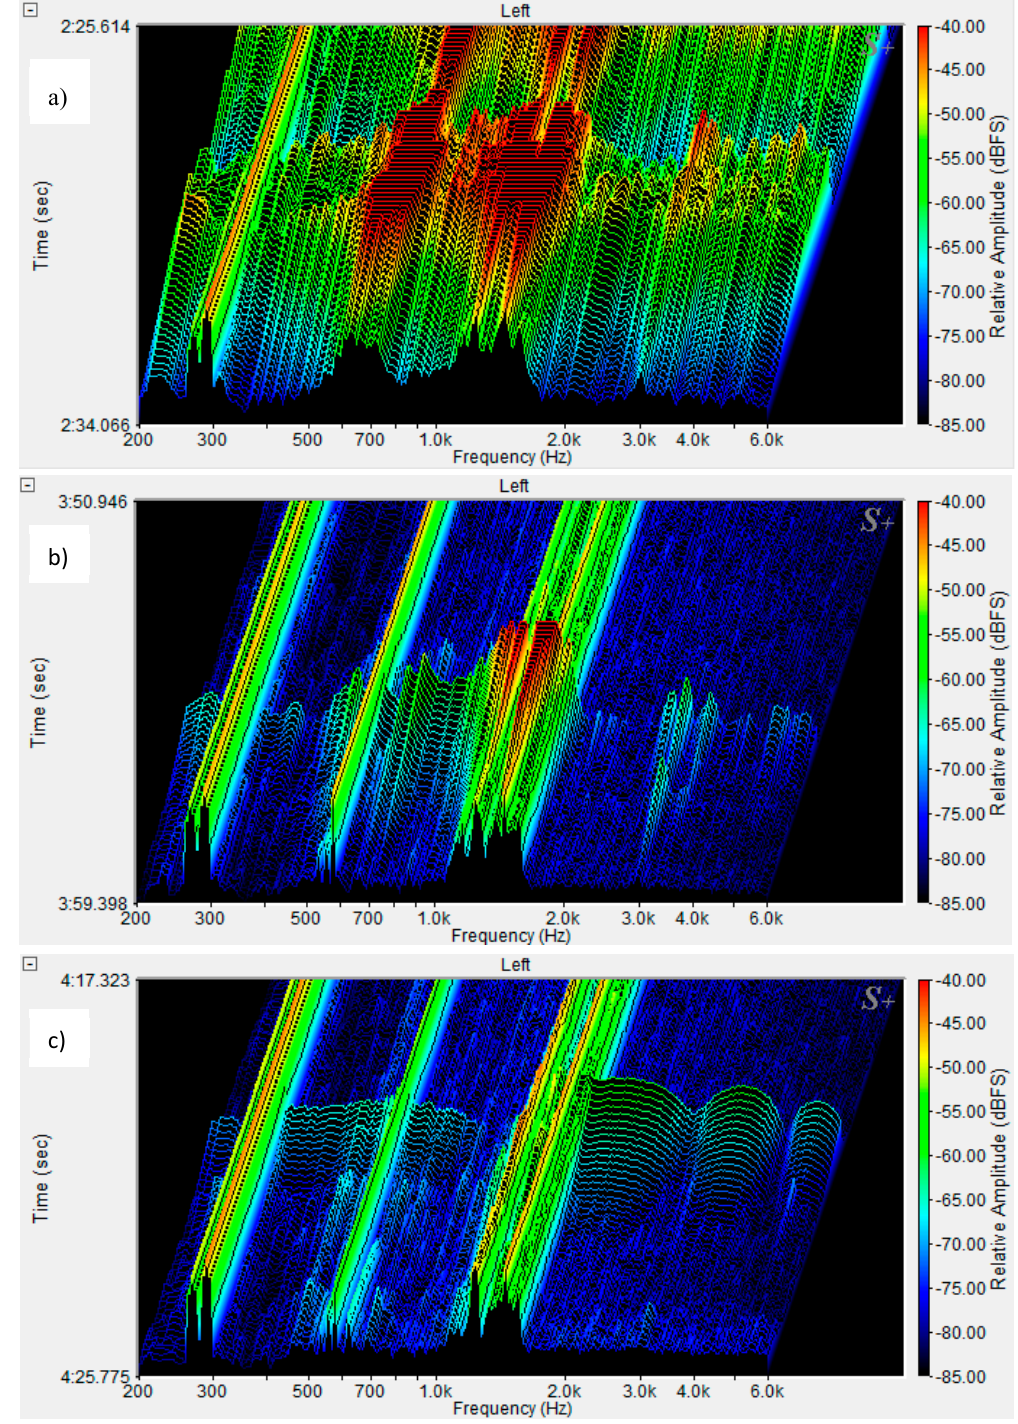
Figure 6. 3D spectra of the ESD composite: ( a ) macrocrack, ( b ) fiber destruction, ( c ) fiber pull-out.